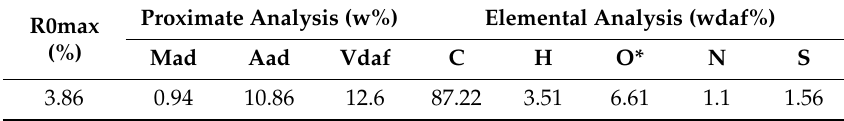
Table 1. Proximate analysis and elemental analysis of the coal samples from AW